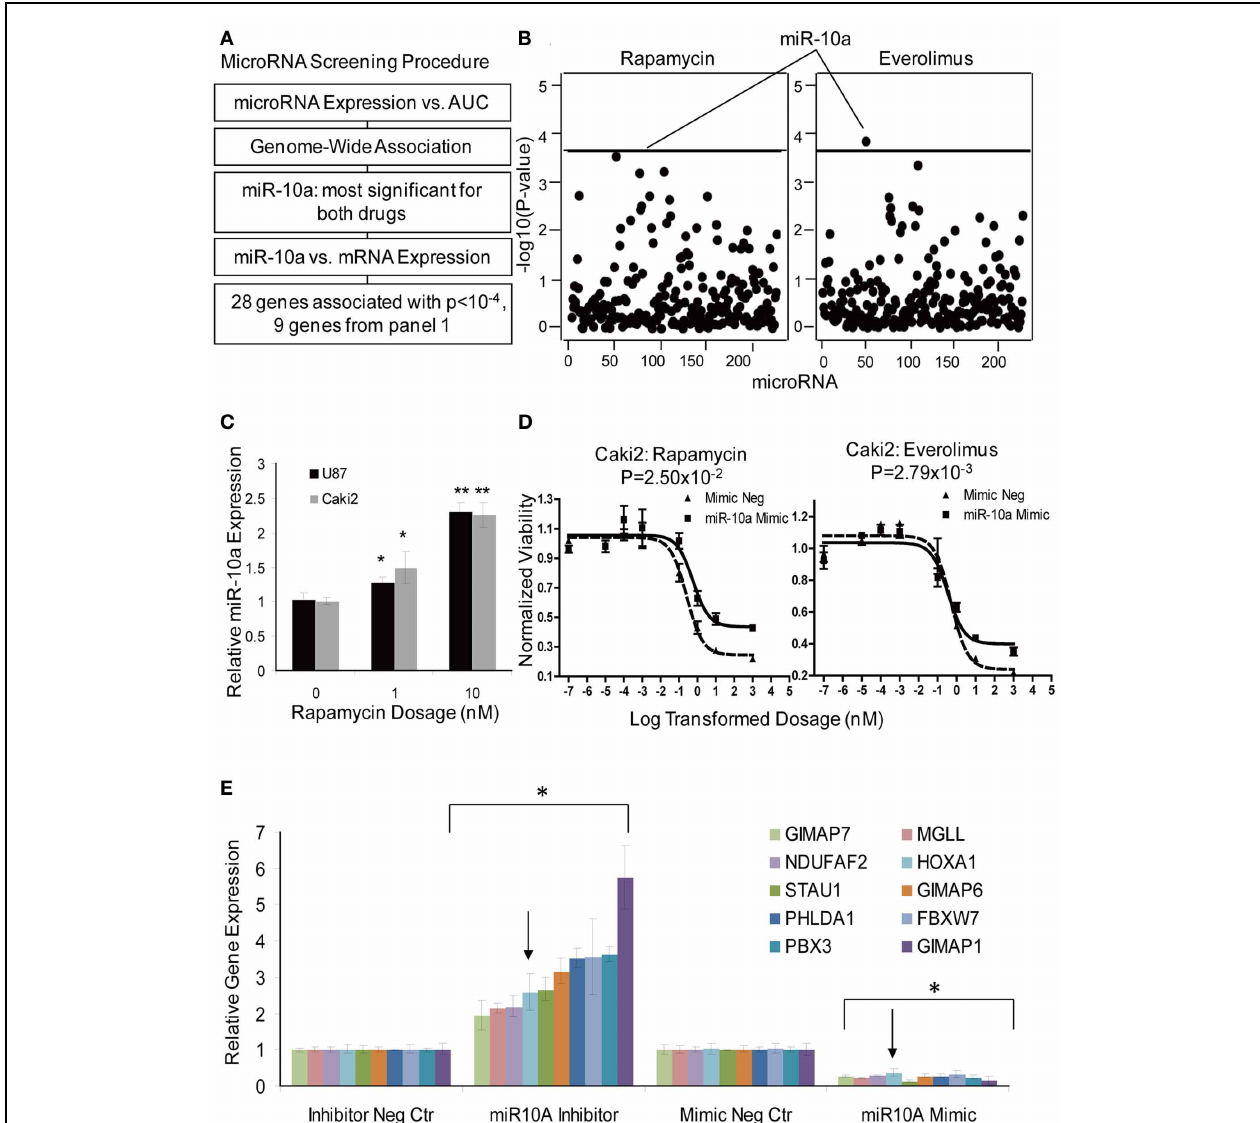
FIGURE 5 | MicroRNA screening and functional validation of miR-10a. (A) Schematic diagram of the strategy used to select microRNAs for functional validation. (B) Genome-wide associations of microRNAs with AUC values for Rapamycin and Everolimus. MiR-10a was the most significant microRNA associated with AUC values for both Rapamycin and Everolimus. The x-axis represents 226 microRNA probes, and the y-axis represents the − log 10 ( P -value) for the association of individual microRNA probe sets. A − log 10 ( P -value) of 3.66 is highlighted with a horizontal line, indicating a p -value with genome-wide significance after Bonferroni correction for 228 tests. (C) Effect of Rapamycin on miR-10a